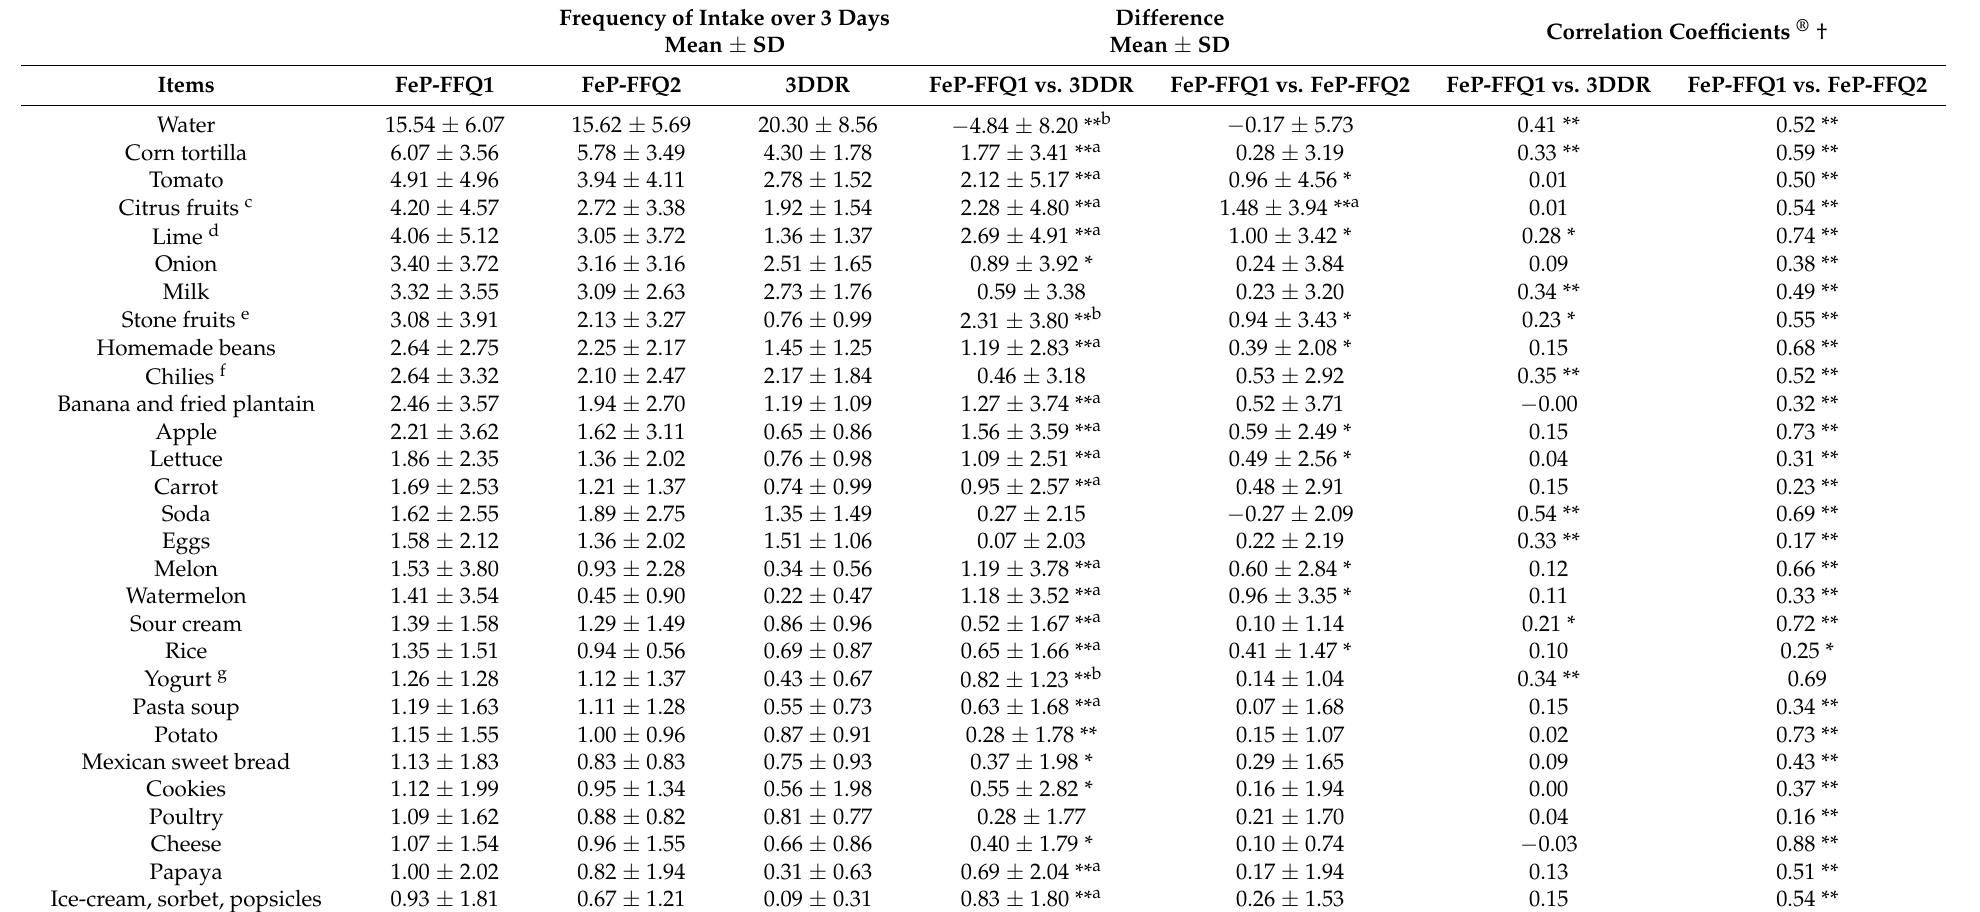
Table 2. Estimated intake and comparisons between FeP-FFQ1, FeP-FFQ2 & 3DDR ( n =